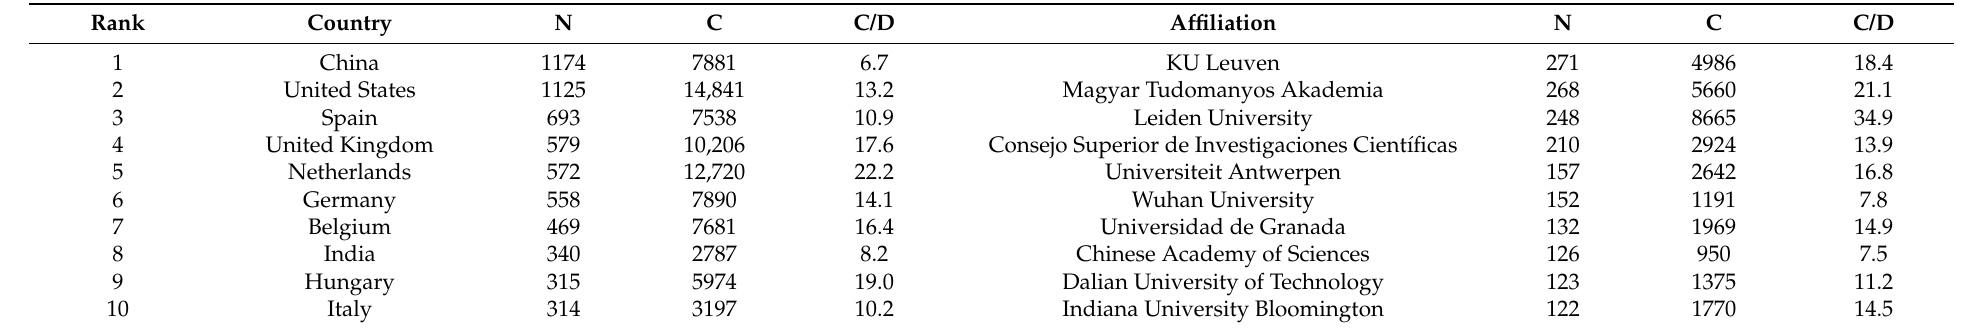
Table 9. Top 10 countries and affiliations publishing in Scientometrics